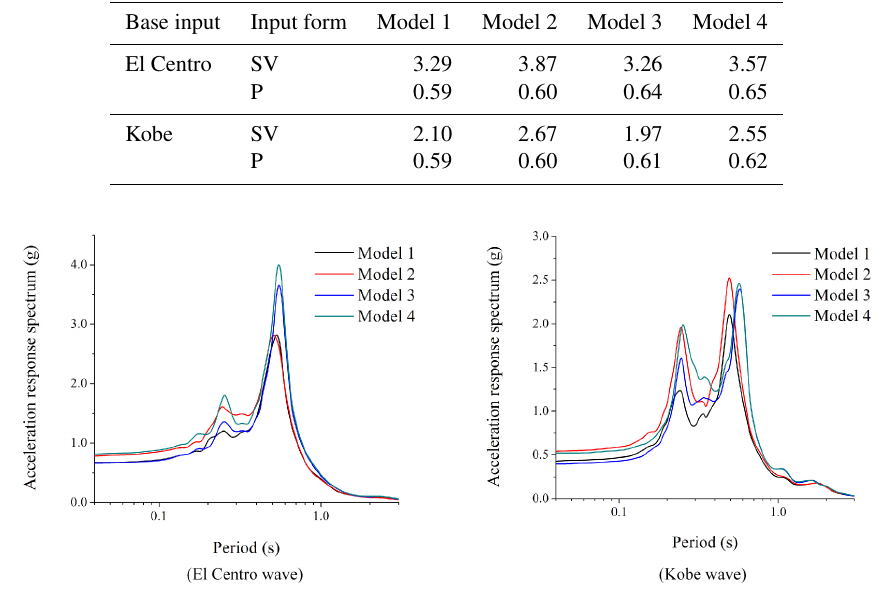
Figure 3. Acceleration response spectrum of point A of four free-field models in the form of SV input.